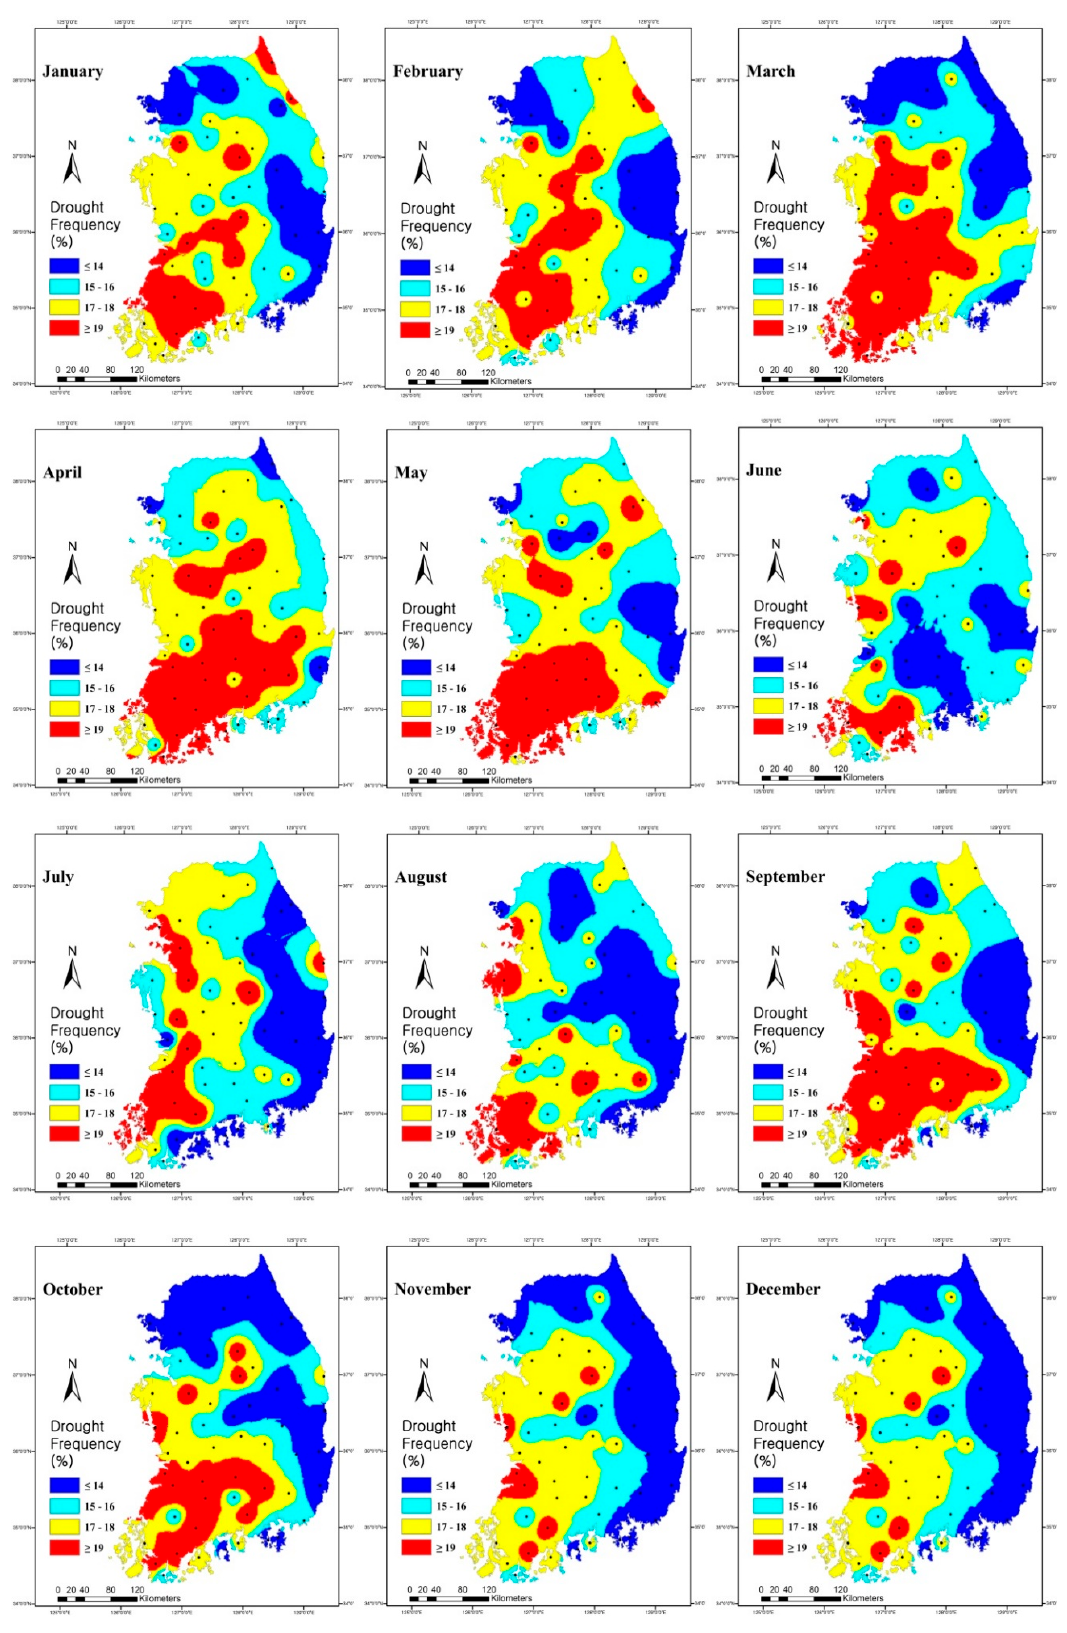
Figure 12. Spatial distribution of relative frequency of drought (%) based on SPI-12 time series (less than − 1) for 55 stations across South Korea.